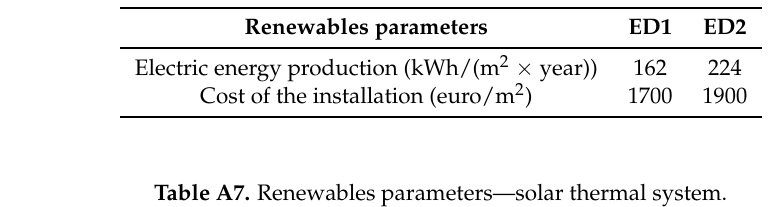
Table A7. Renewables parameters—solar thermal system.